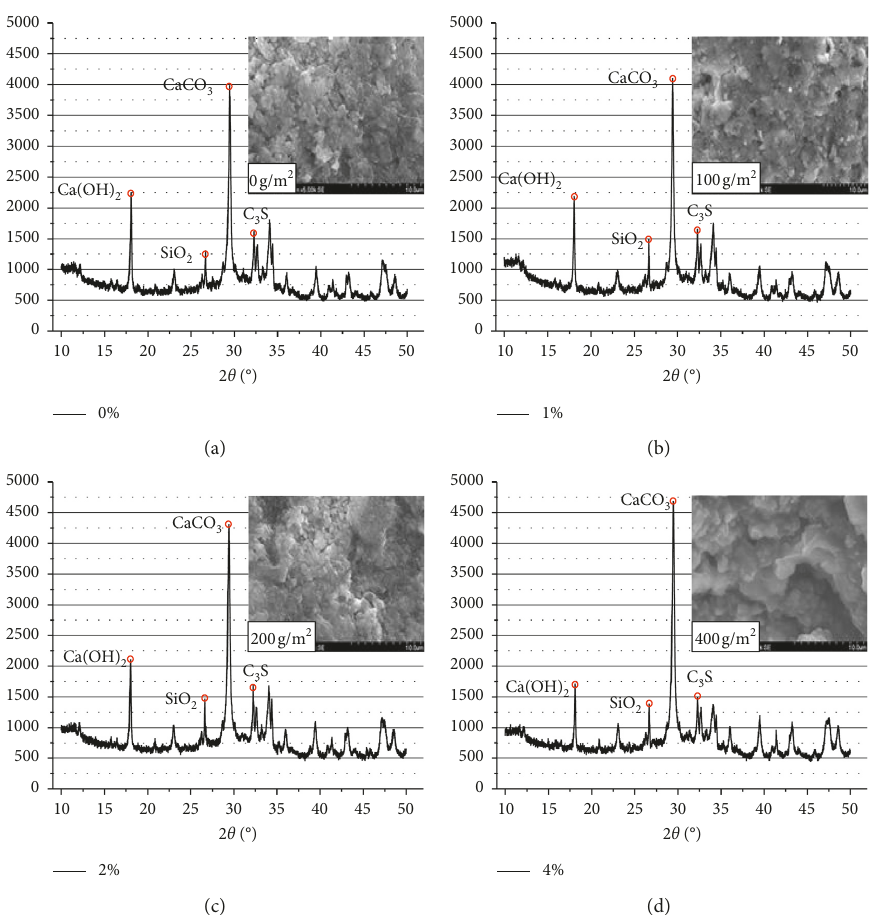
Figure 2: Composition and microstructure analysis via X-ray and SEM. (a) 0%. (b) 1%. (c) 2%. (d) 4%.